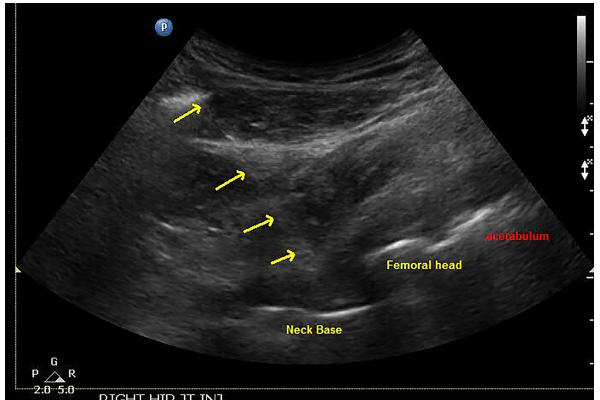
Figure 3. Ultrasound image with needle placement and labeled as- pects of a total hip (neck, femoral head, and acetabulum).